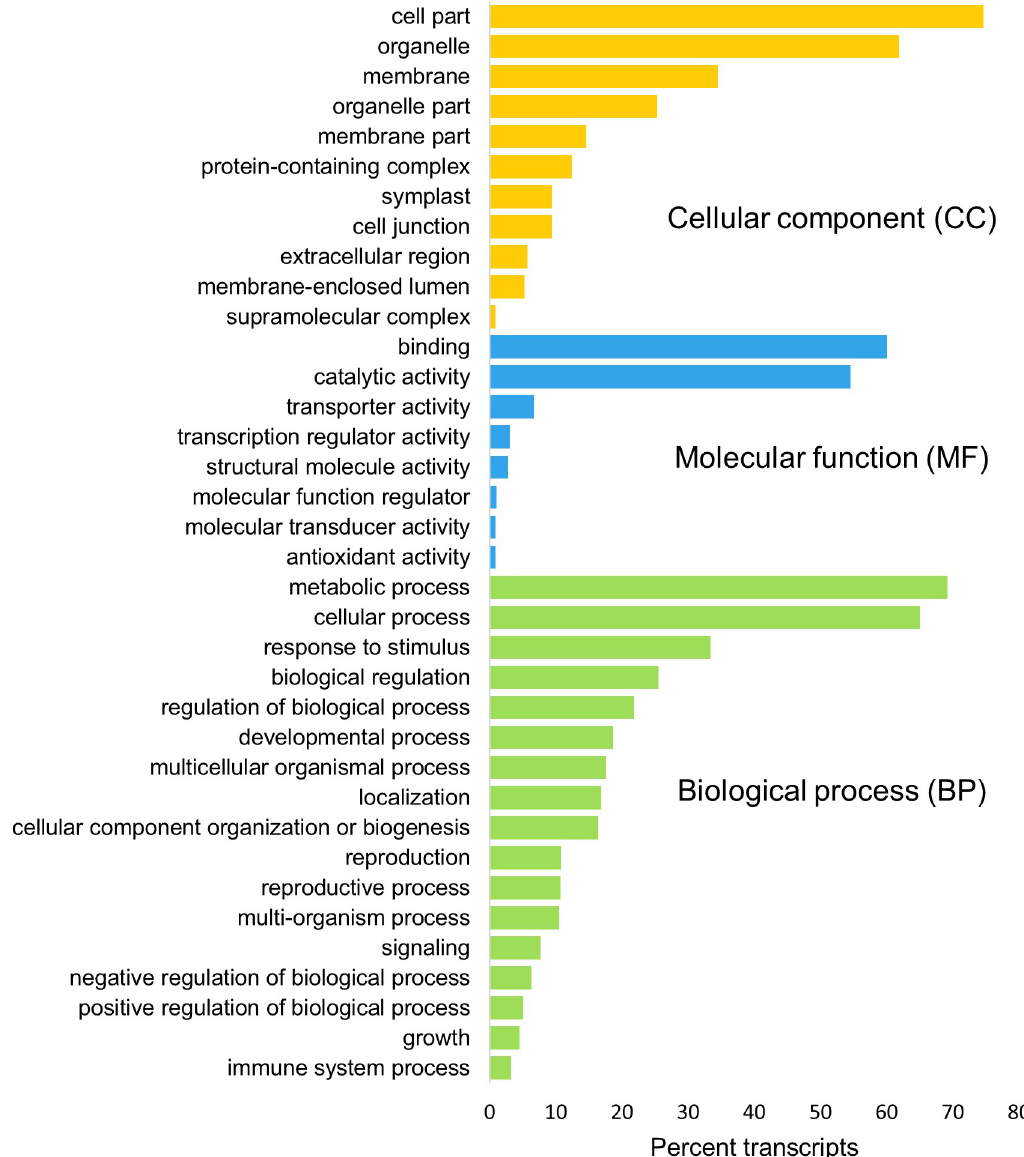
Fig 1. Gene ontology (GO) level 2 classification and proportion of assembled transcripts from Hypoxis hemerocallidea . Classification is grouped under the GO domains: ‘cellular component’, ‘molecular function’ and ‘biological